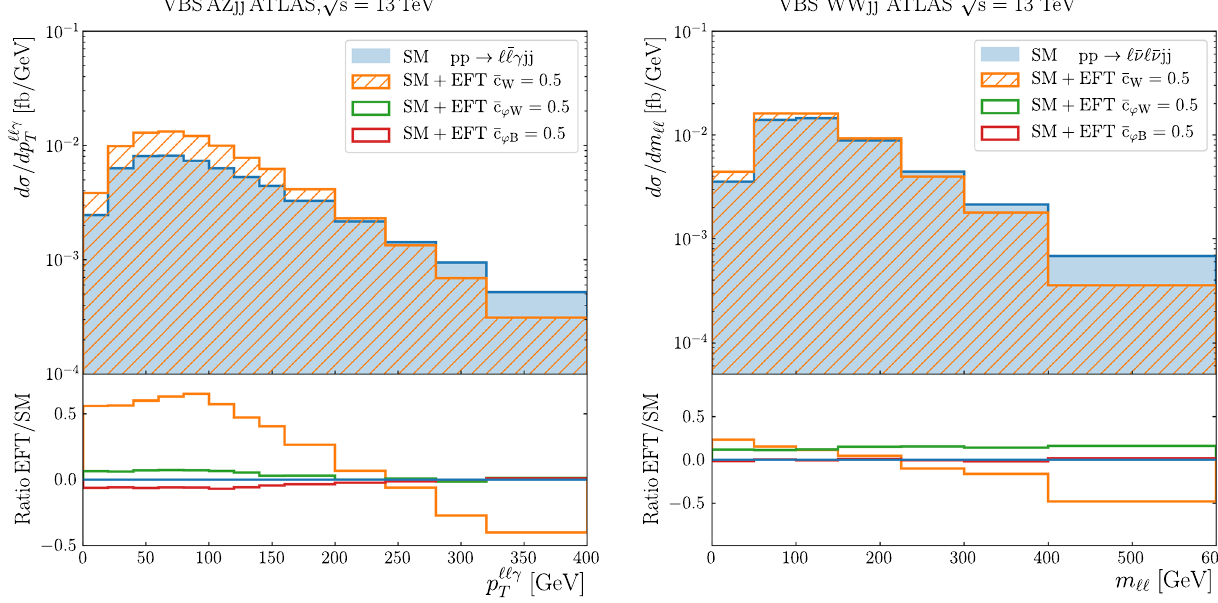
Fig. 13 Theoretical predictions for the VBS signal (EW-induced com- with three EFT benchmark points in terms of the dimensionless quan- √ s = 13 TeV. We show the tities ¯ c = c v 2 /Λ 2 . Either ¯ c W , ¯ c ϕ W , or ¯ c ϕ B are set to 0 . 5 and the other ponent only) for different final states at dilepton p T γ(cid:10)(cid:10) distributions for the γ Zjj (left) and m (cid:10)(cid:10) for W ± W ± jj coefficients to zero. In the upper panels, only the EFT prediction with ¯ c = 0 . 5 are shown to improve readability (right) final states based on the selection cuts of the corresponding W ATLAS measurements. In each case, we compare the SM predictions